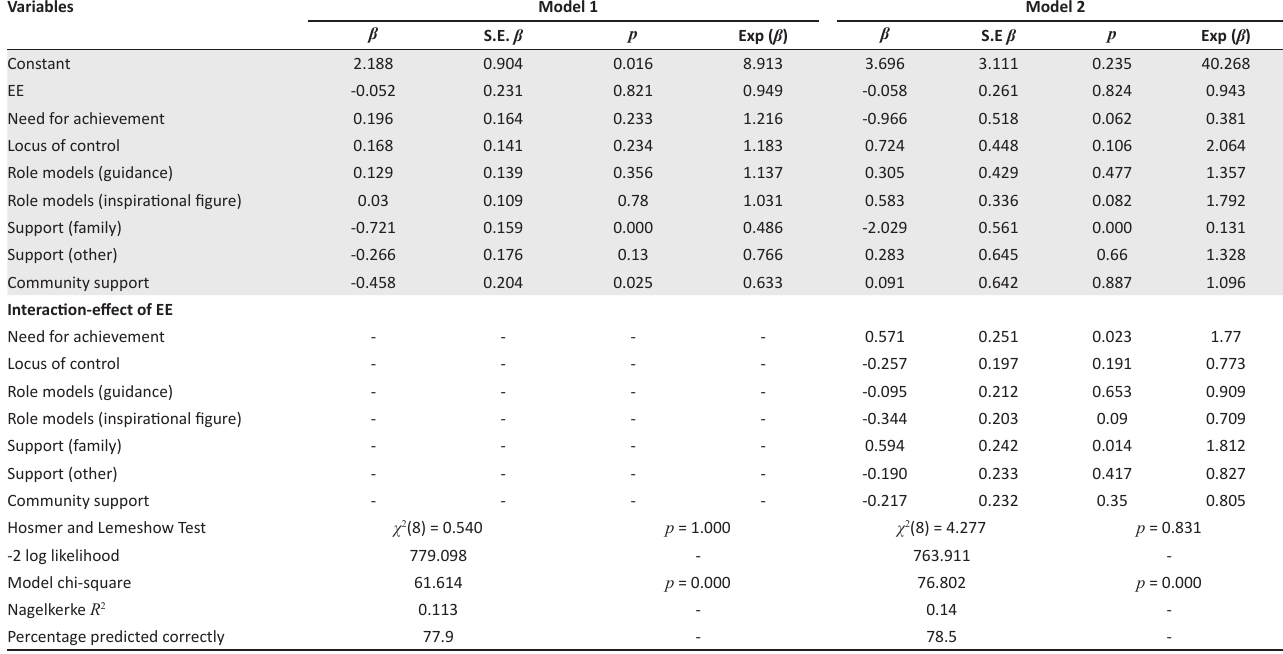
TABLE 3: Logistic regression analysis results for entrepreneurial